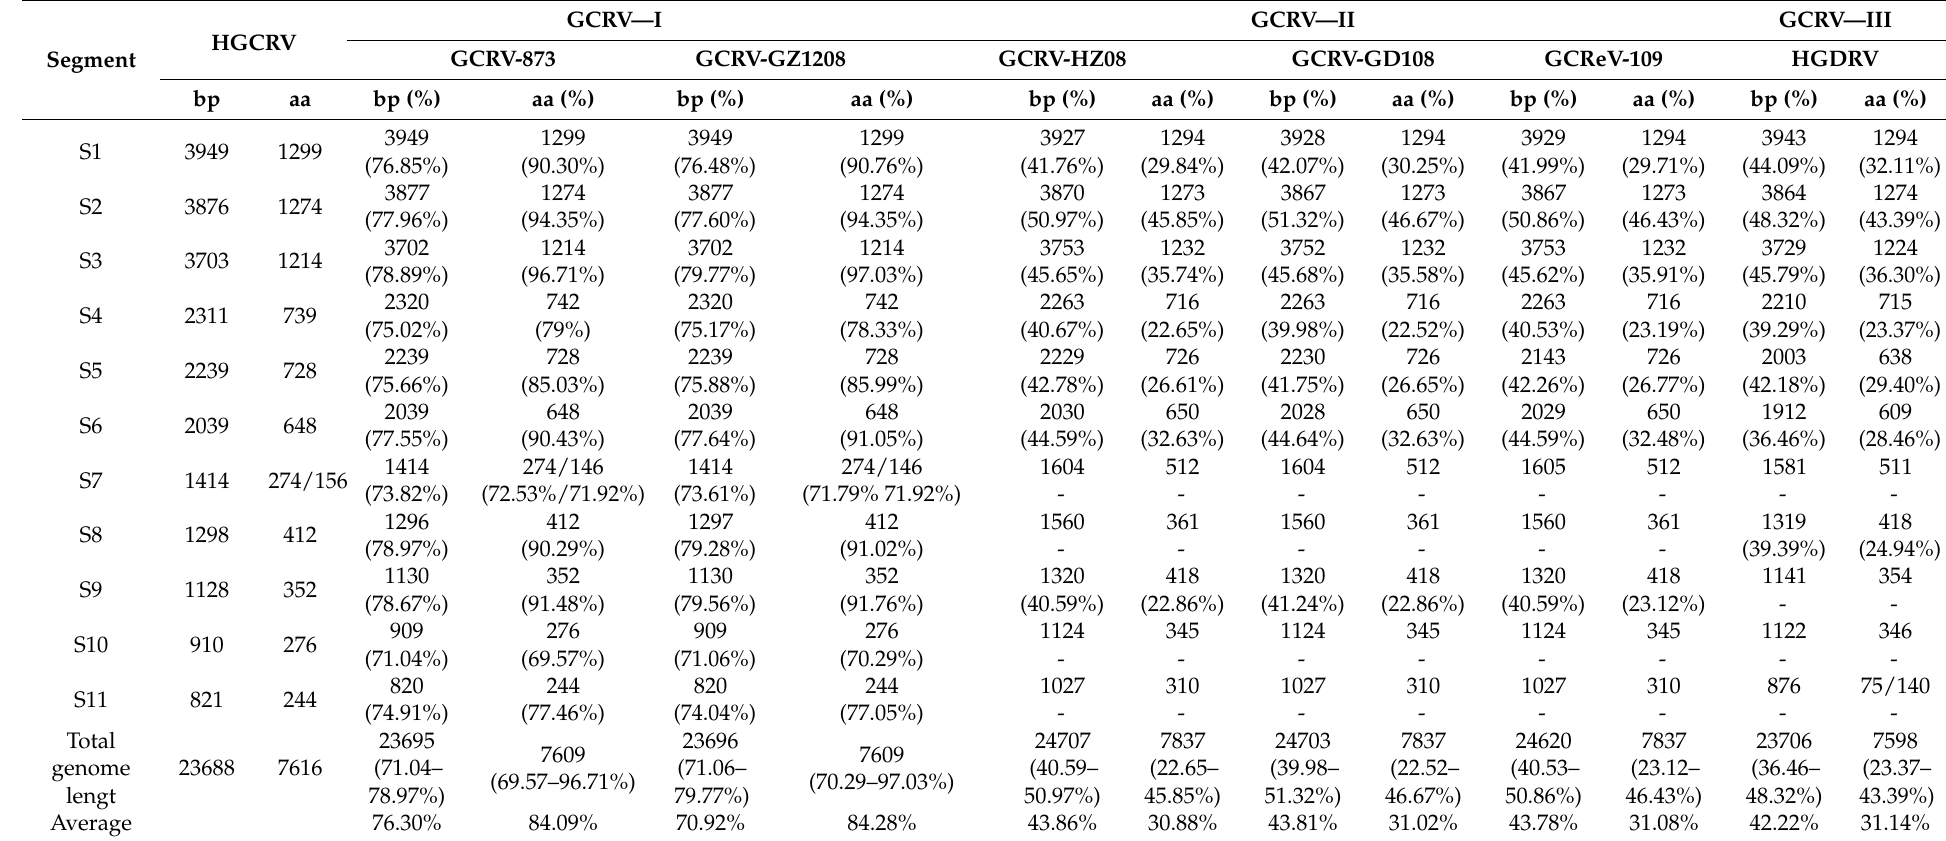
Table 3. Comparison of nucleotide and amino acid sequence identity between HGCRV and other GCRV